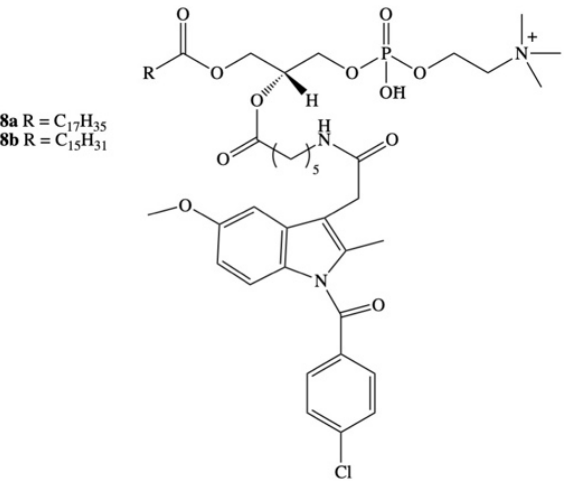
Figure 6. Chemical structure of phospholipid derivatives of indomethacin DP-155.